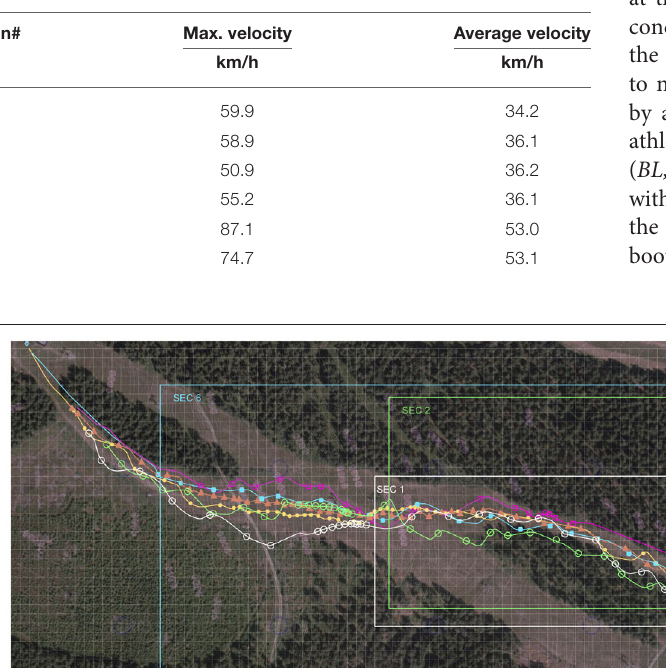
Frontiers in Sports and Active Living |